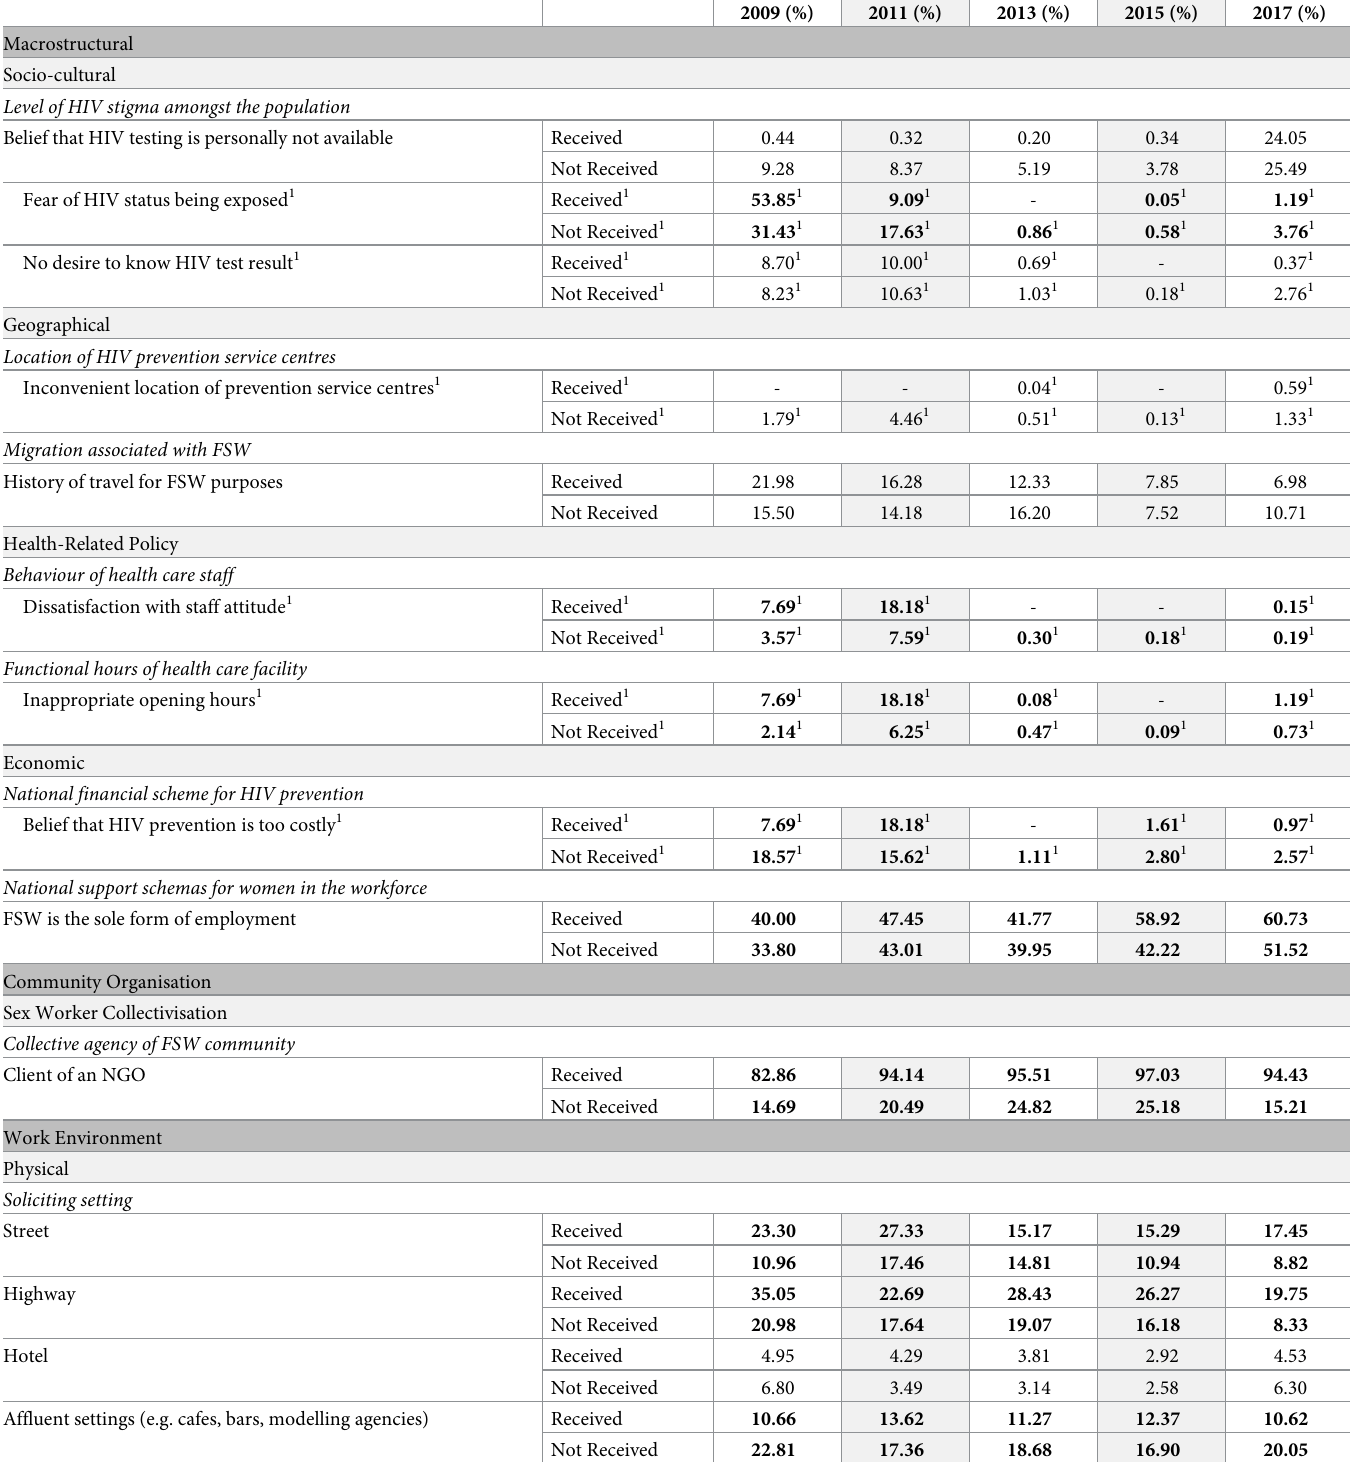
Table 1. Barriers and facilitators to accessing HIV prevention stratified by receipt or non-receipt of basic PP between 2009 and